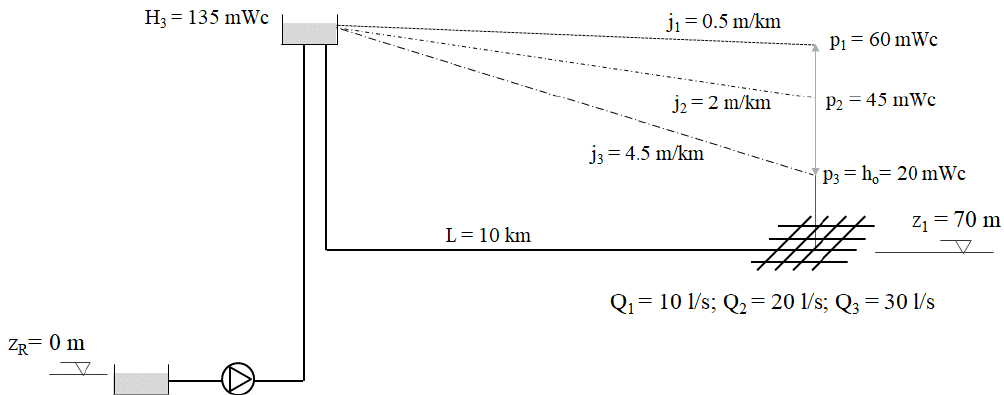
Figure 2. Energy surplus delivered in a flat area from a tank located higher than necessary.